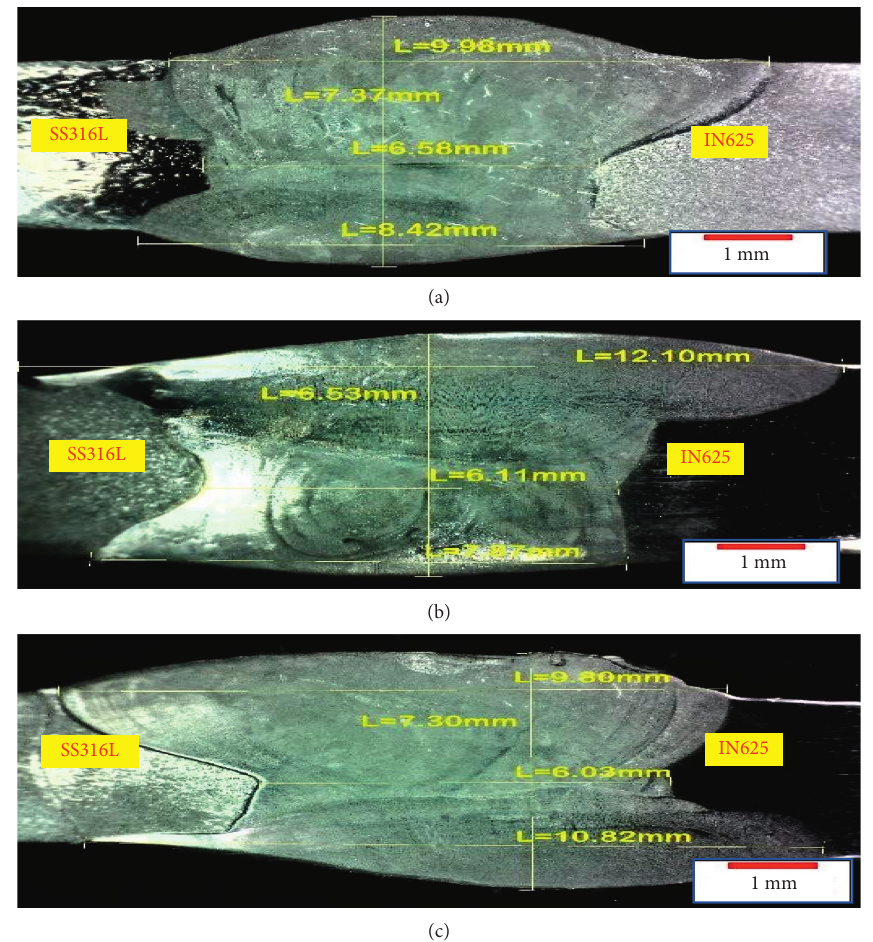
Figure 7: Weld bead geometry: (a) trial-1, (b) trial-2, and (c) trial-3.